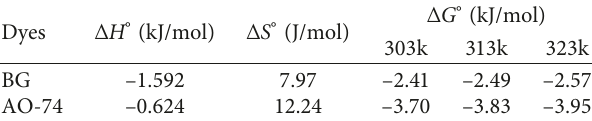
Table 3: Langmuir parameters for removal of dyes by PR